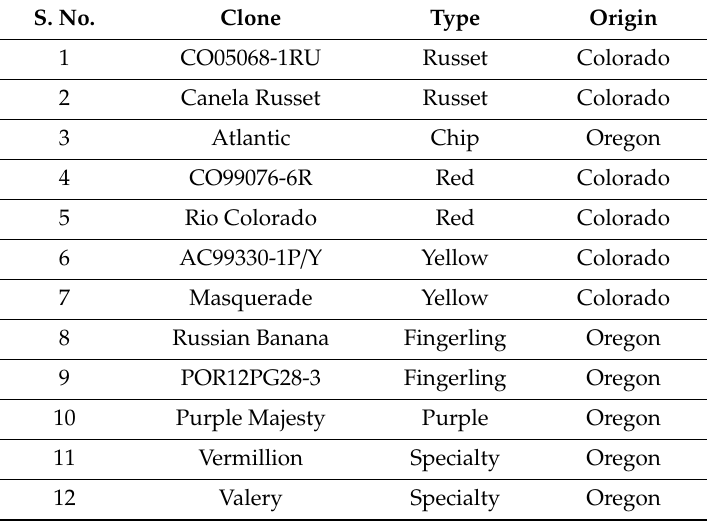
Table 1. Potato cultivars used in the